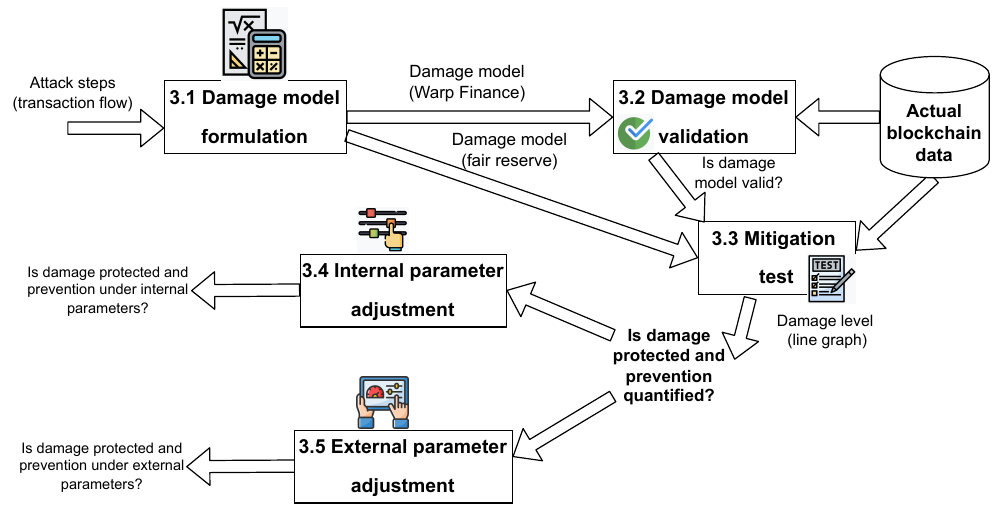
Figure 1. System overview of the FAA